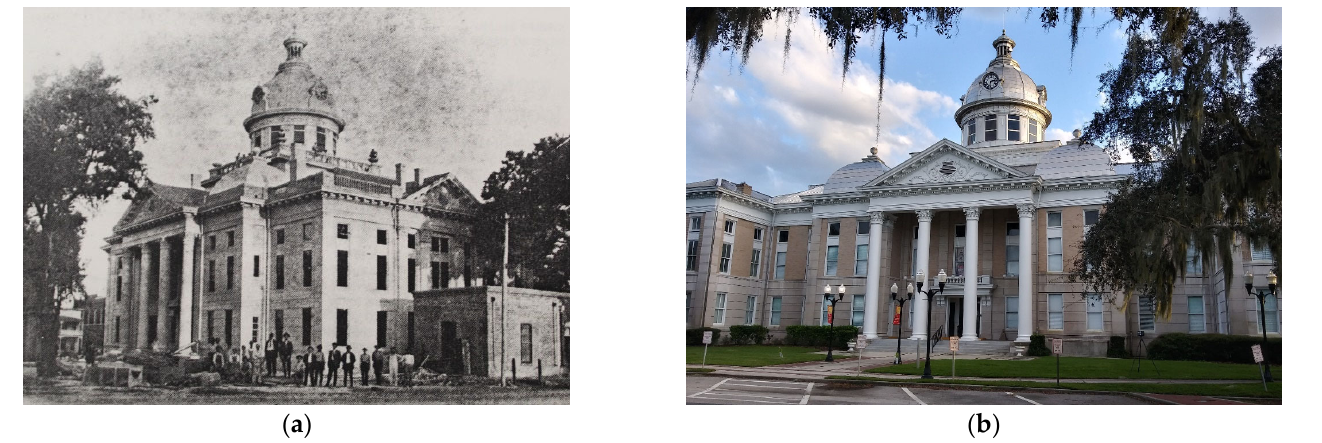
Figure 9. The Old Polk County Courthouse (OPCC): ( a ) workmen stood next to the newly completed courthouse in 1909 [69]; ( b ) present ‐ day view of the building.